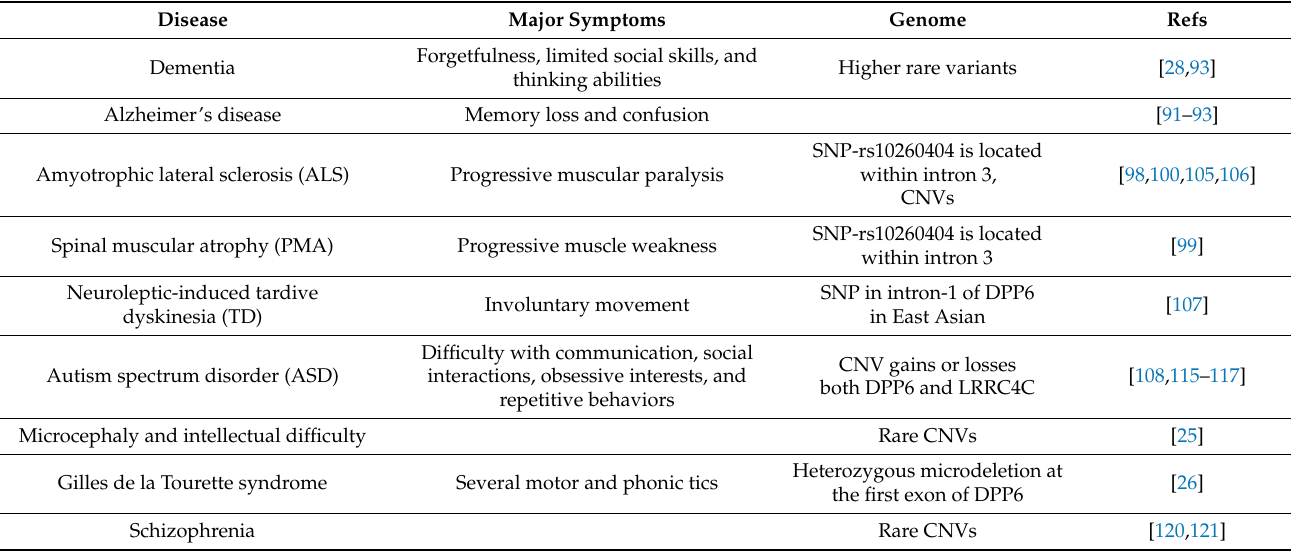
Table 1. DPP6-related